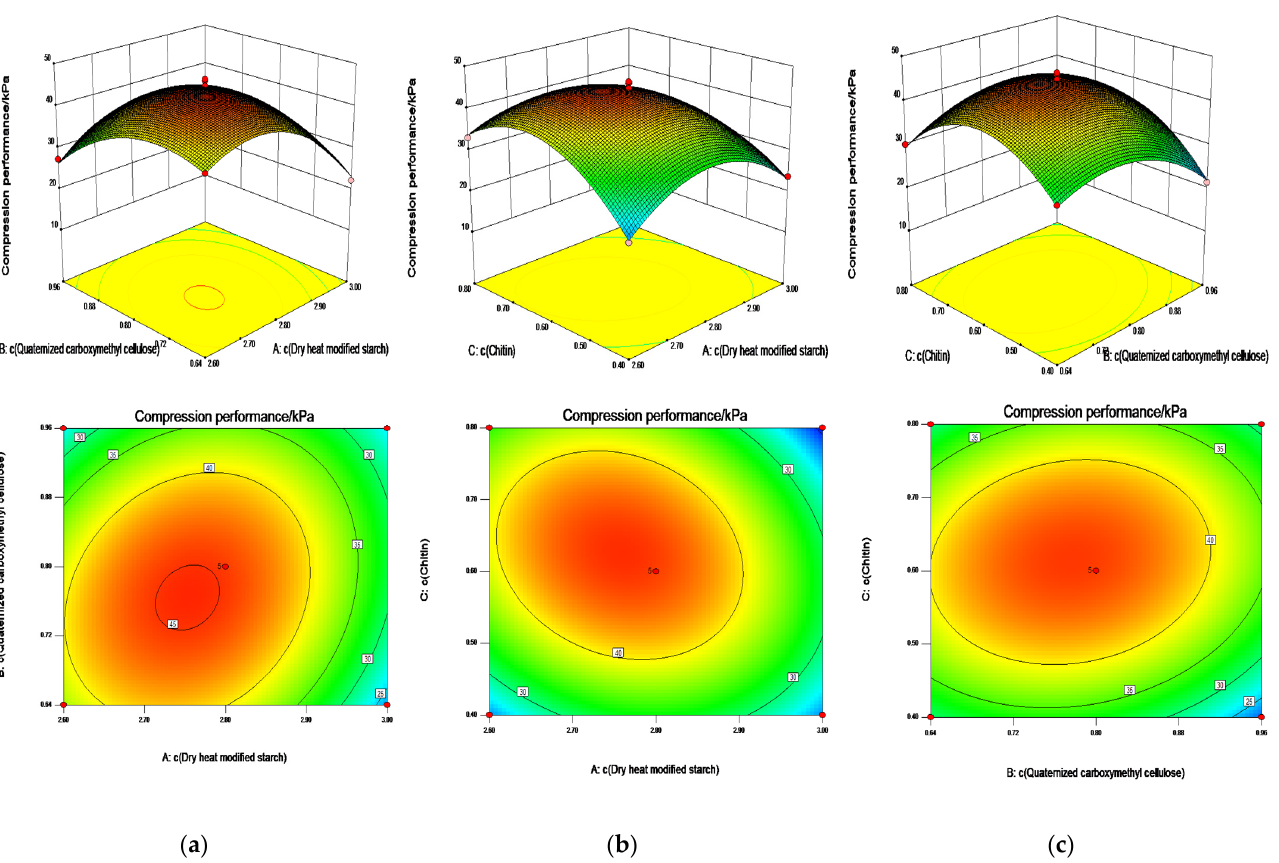
Figure 5. Contour and 3D response plots showing the effects of ( a ) concentration of dry heat-modified starch (A), concentration of quaternized carboxymethyl cellulose (B), and their interaction on the compression performance; ( b ) concentration of dry heat-modified starch (A), concentration of chitin (C), and their interaction on the compression performance; ( c ) concentration of quaternized carboxymethyl cellulose (B), concentration of chitin (C), and their interaction on the compression